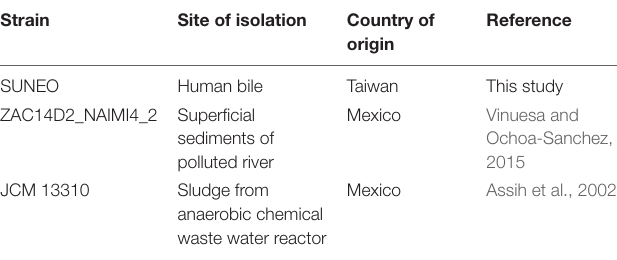
TABLE 1 | Overview of the S. acidaminiphila strains in this study.